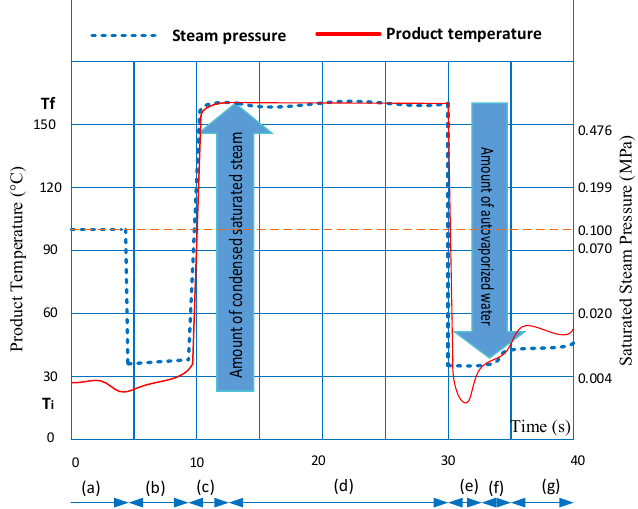
Figure 2. DIC stages applied on mangoes: ( a ) placement of samples into the reactor under atmospheric pressure; ( b ) establishment of initial vacuum; ( c ) injection of saturated steam; ( d ) holding of target saturated steam pressure; ( e ) instant controlled pressure drop towards the vacuum; ( f ) holding of vacuum; ( g ) release of samples at atmospheric pressure.